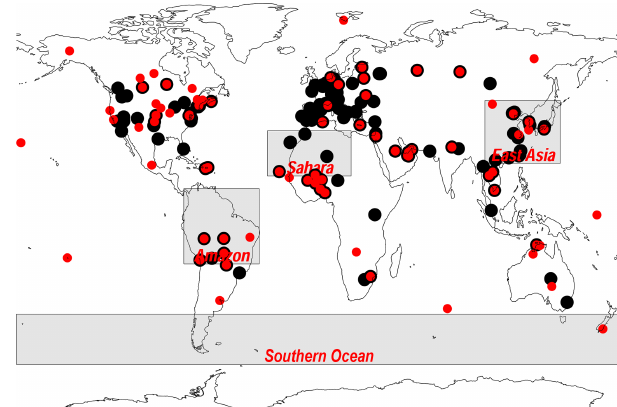
Figure 7. AERONET stations and regions used in the monthly sum- maries for AOT, AE (direct sun measurements, red symbols), and SSA (version 2 inversion product, black symbols; Holben et al., 2006) for 2007 in Fig. 8. The stations for the AOT and AE sum- maries are selected as being regionally representative, as in Kinne et al.